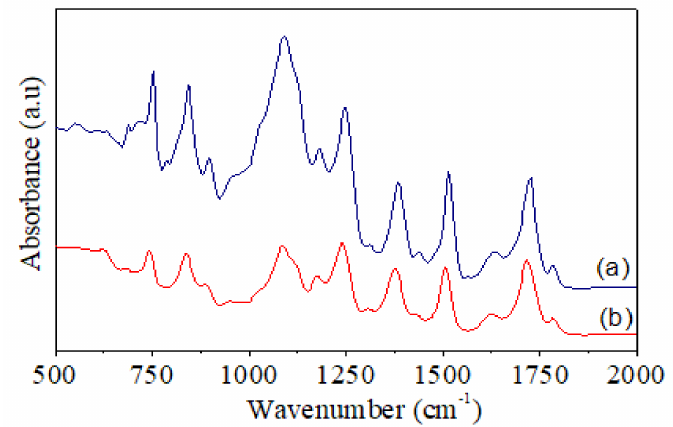
Figure 6. FT-IR spectra of ( a ) pure PI and ( b ) PI-TSi-GPMS50.